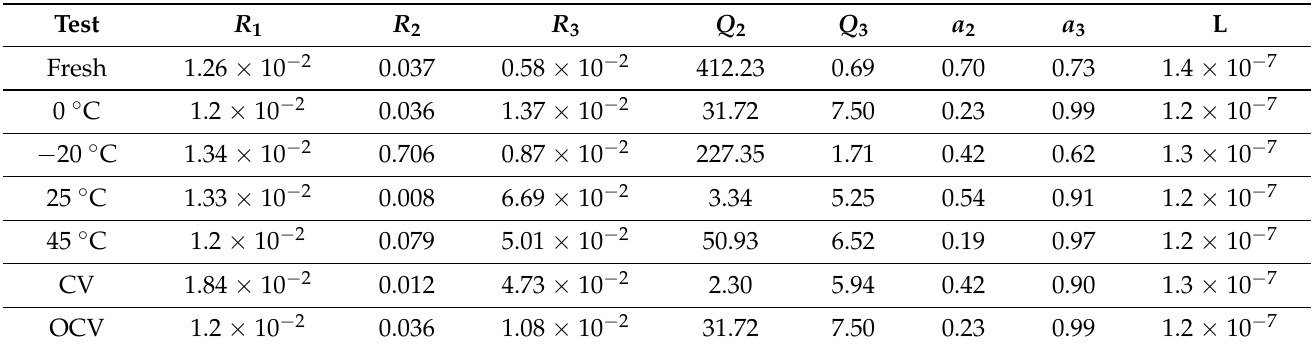
Figure 6. EIS results based on equivalent circuit L 1 + R 1 + Q 2 // R 2 + Q 3 // R 3 at SOC = 60%. ( a ) Comparison of inductance values. ( b ) Comparison of ohmic resistances. ( c ) Comparison of the interface resistance according to the interface capacitance. ( d ) Comparison of the charge transfer resistance according to the charge transfer capacitance.